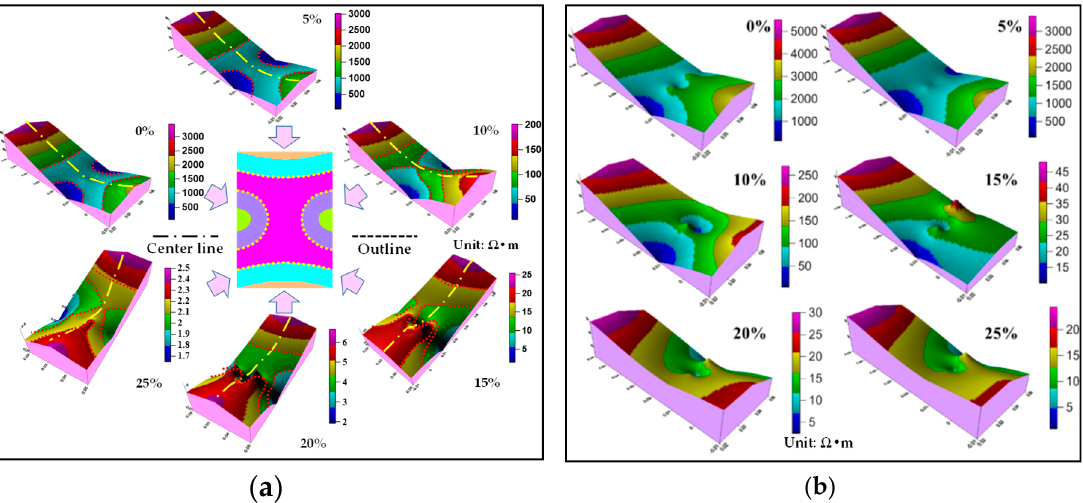
Figure 12. Spatial distributions of apparent resistivity in specimens before failure and after failure. ( a ) Before failure. ( b ) After failure.